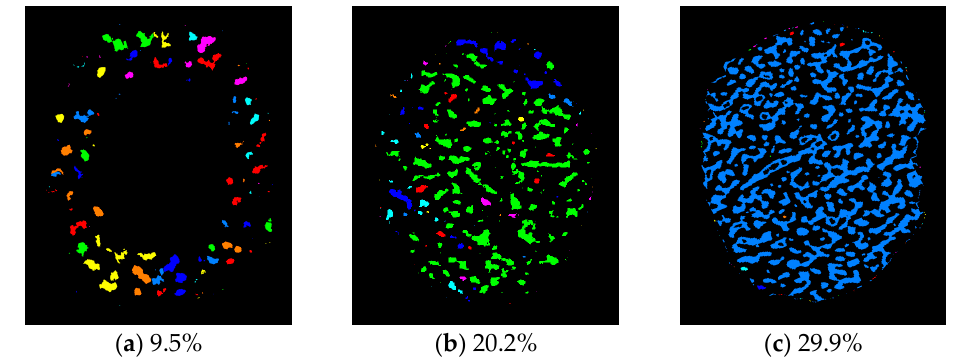
Figure 4. Pore distribution characteristics for different mass losses of AP.